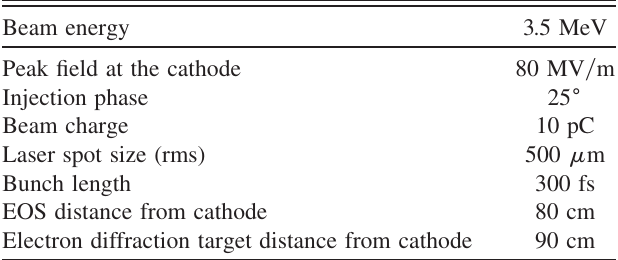
TABLE I. Pegasus photoinjector parameters for electro-optic based time stamping.